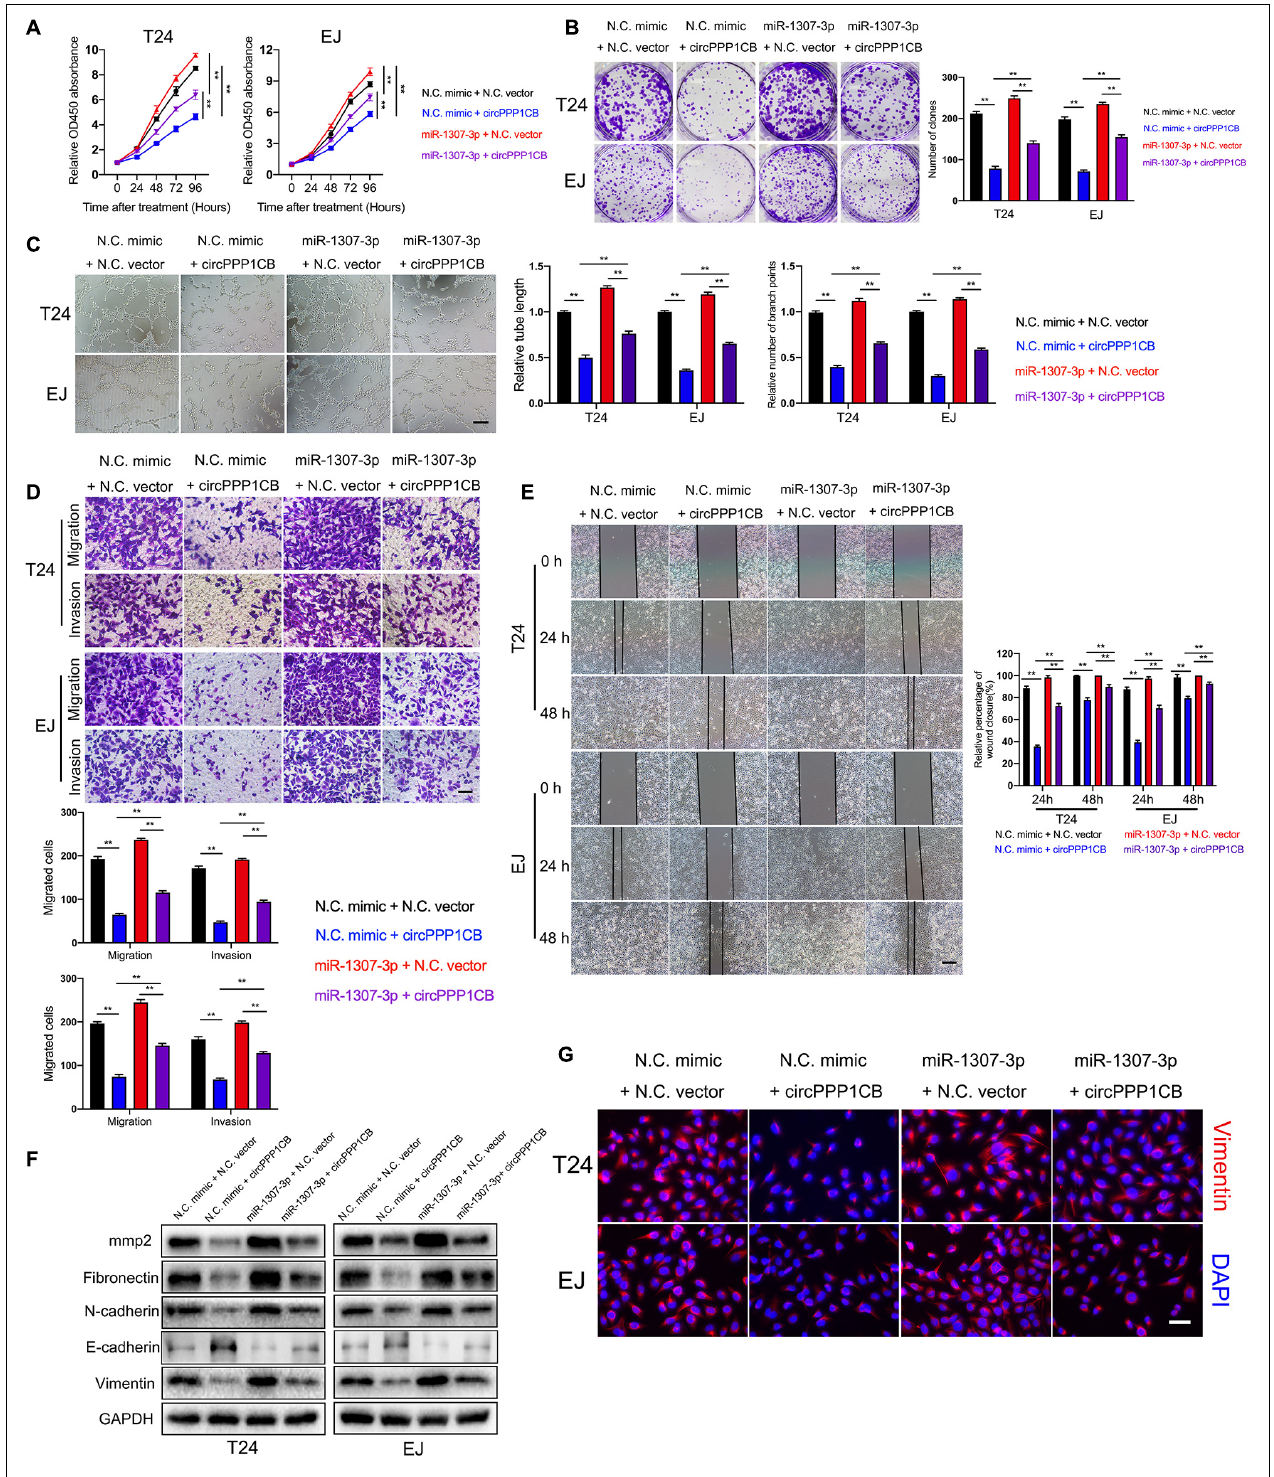
FIGURE 4 | MiR-1307-3p reverses the biological effects induced by circPPP1CB. (A,B) Cell proliferation and colony formation ability were evaluated in cells under different conditions by CCK-8 assay and colony formation assay, respectively. (C) HUVECs were cultured with conditional media acquired from different bladder cancer cells to determine effects of miR-1307-3p and circPPP1CB on tumor angiogenesis. Scale bars: 400 µ m. (D–F) The biological effects of circPPP1CB and miR-1307-3p were determined by transwell assay (scale bars: 200 µ m), cell scratch assay (scale bars: 400 µ m), and western blotting. (G) Expression levels of vimentin in cells were detected by immunofluorescence assay. Scale bars: 200 µ m. ** p < 0.01 vs. control group.